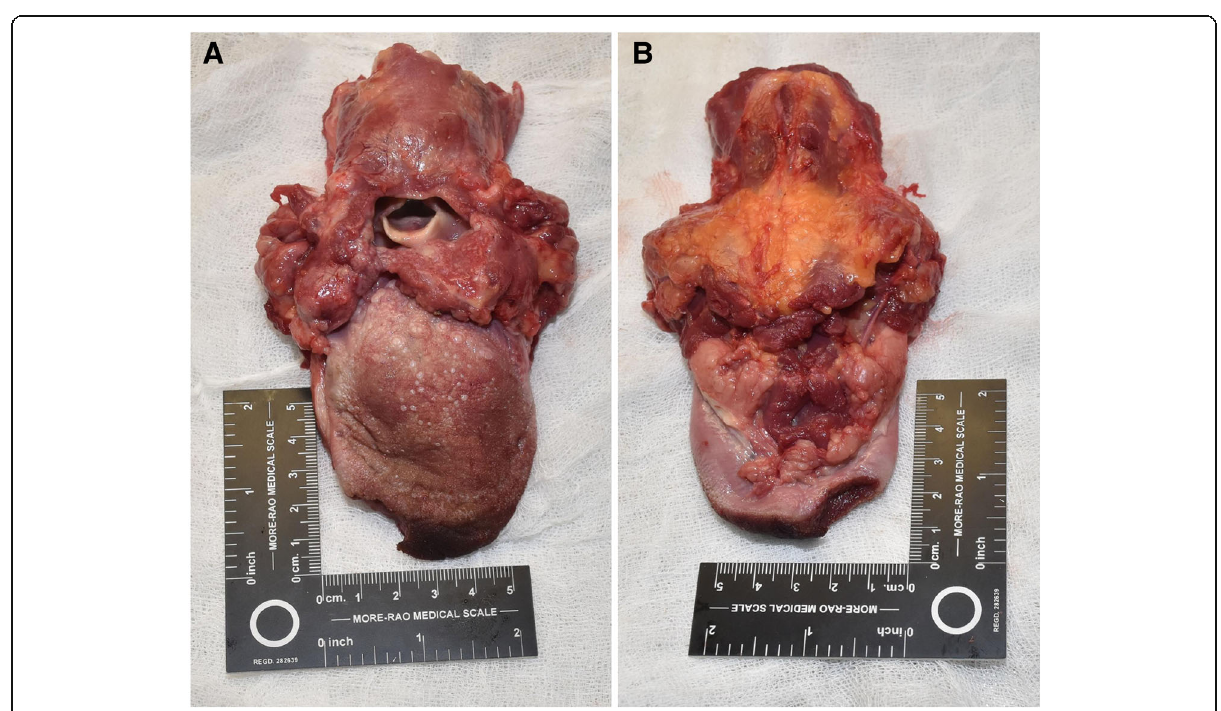
Fig. 4 a , b Post-mortem mutilation of the tongue of the female victim (anterior and posterior